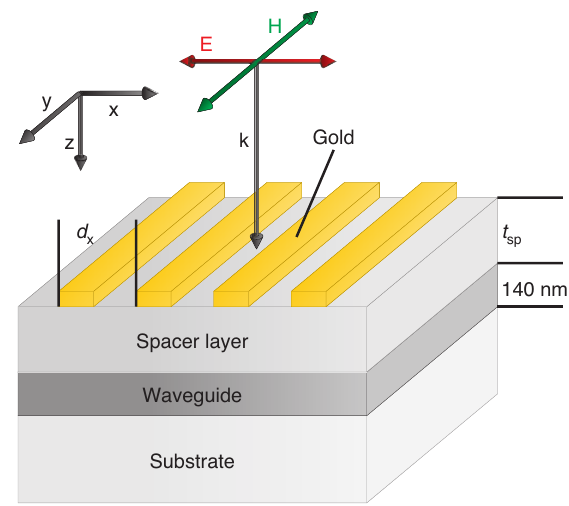
Figure 1: Schematic view of the sample structure. The thickness t of the spacer layer (SiO ) between the 140-nm-thick sp 2 waveguide layer (ITO) and the periodic gold grating is varied between 0 and 350 nm in steps of 50 nm. The grating period d is x varied between 300 and 500